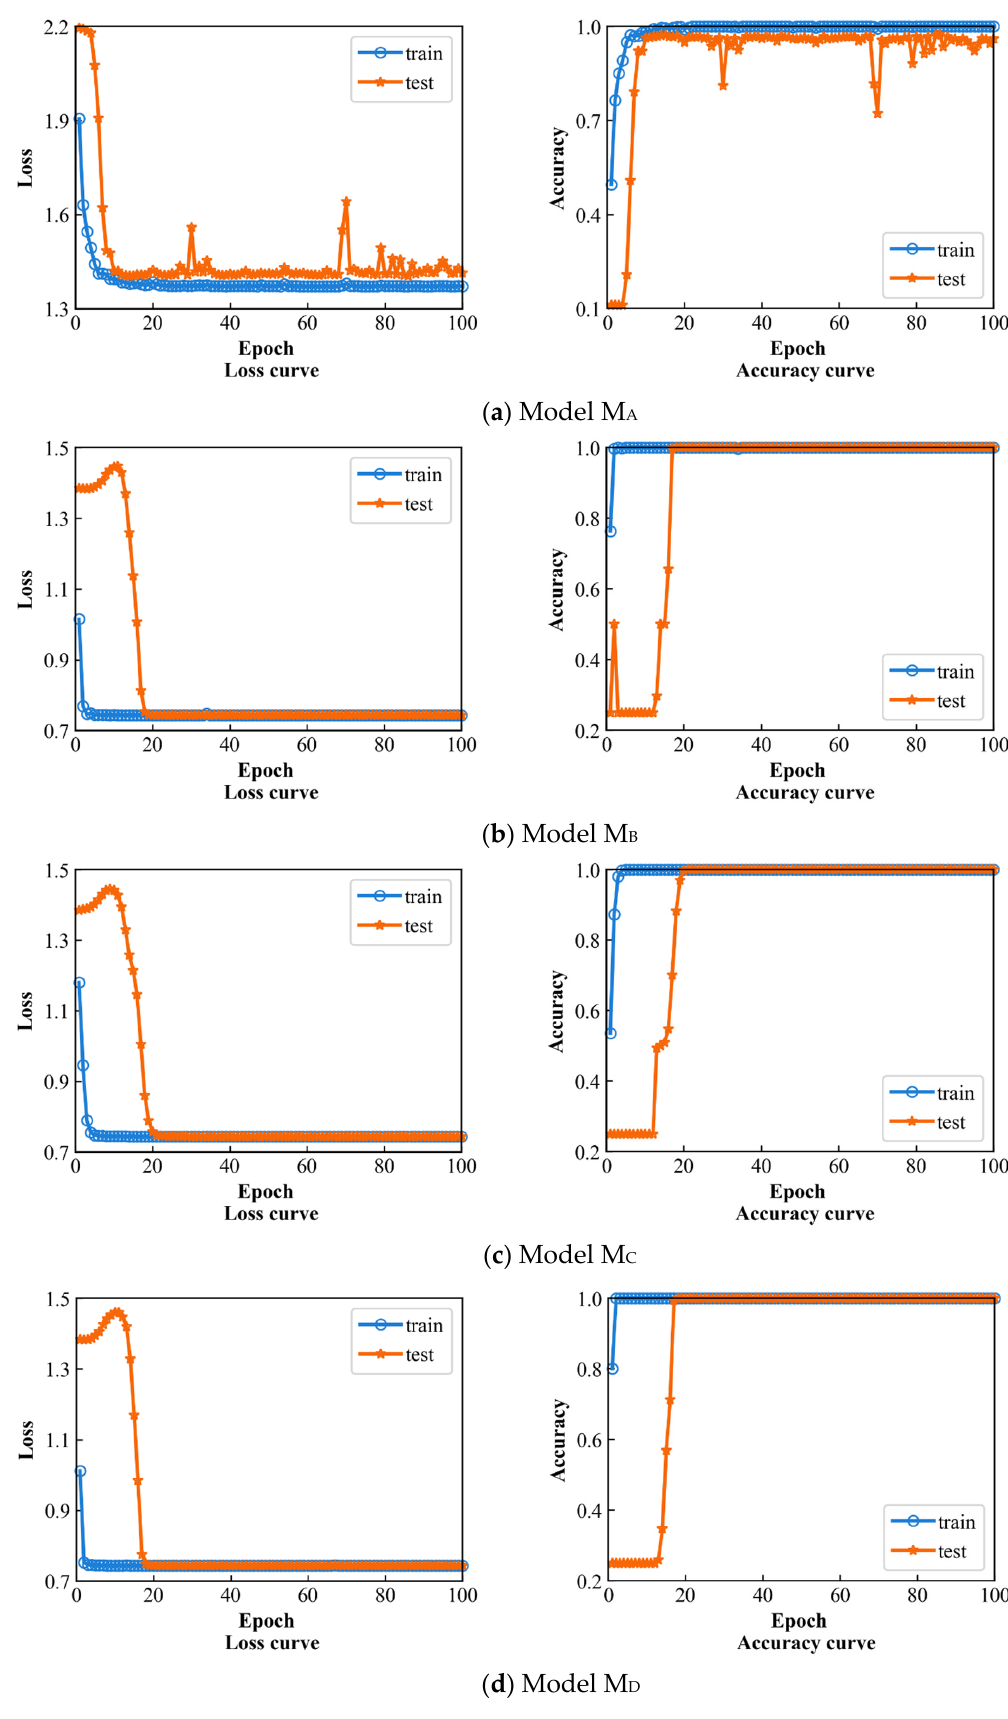
Figure 12. Loss curve and accuracy curves of local fault diagnosis model.